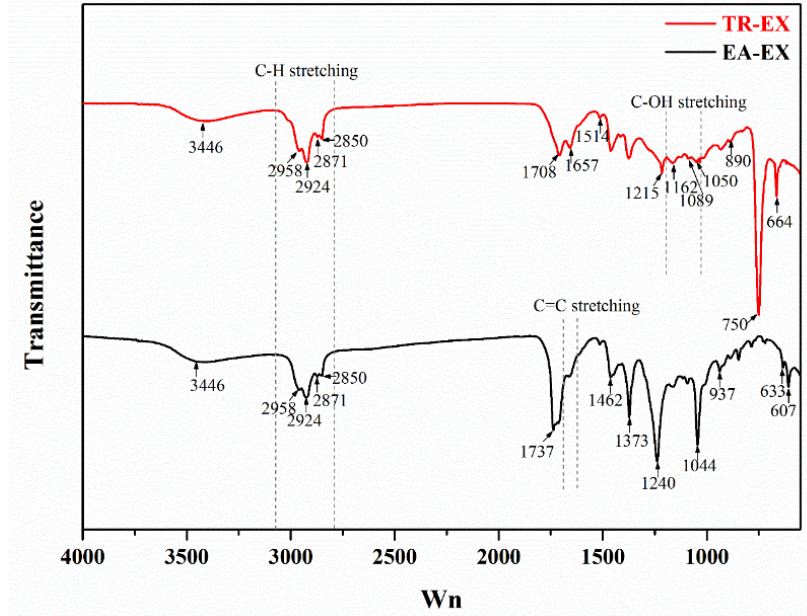
Figure 3. Fourier transform infrared spectroscopy (FTIR) spectra of ethyl acetate extracts (EA-EX) and trichloromethane extracts (TR-EX) from Phoebe zhennan wood.